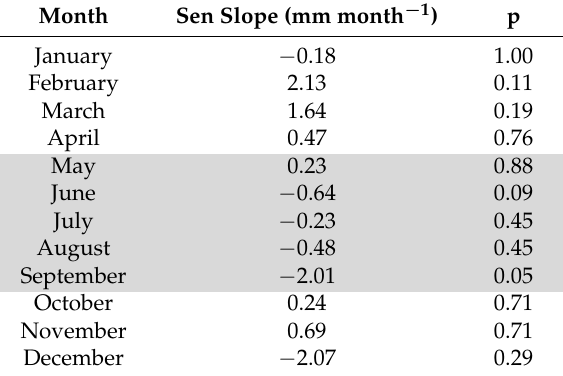
Table 1. Monthly trends of average rainfall values between 1998 and 2015. The shaded months represent the dry season in the Amazon region (mean monthly precipitation less than 100 mm) [66]. Month Sen Slope (mm month − 1 )